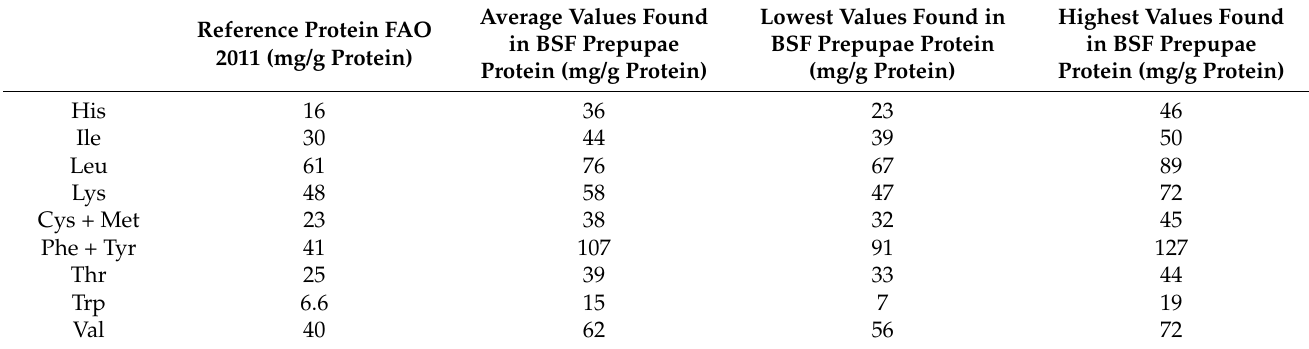
Table 3. Highest, lowest and average essential amino acid content of BSF prepupae, compared with the FAO protein reference for human adults (2011).